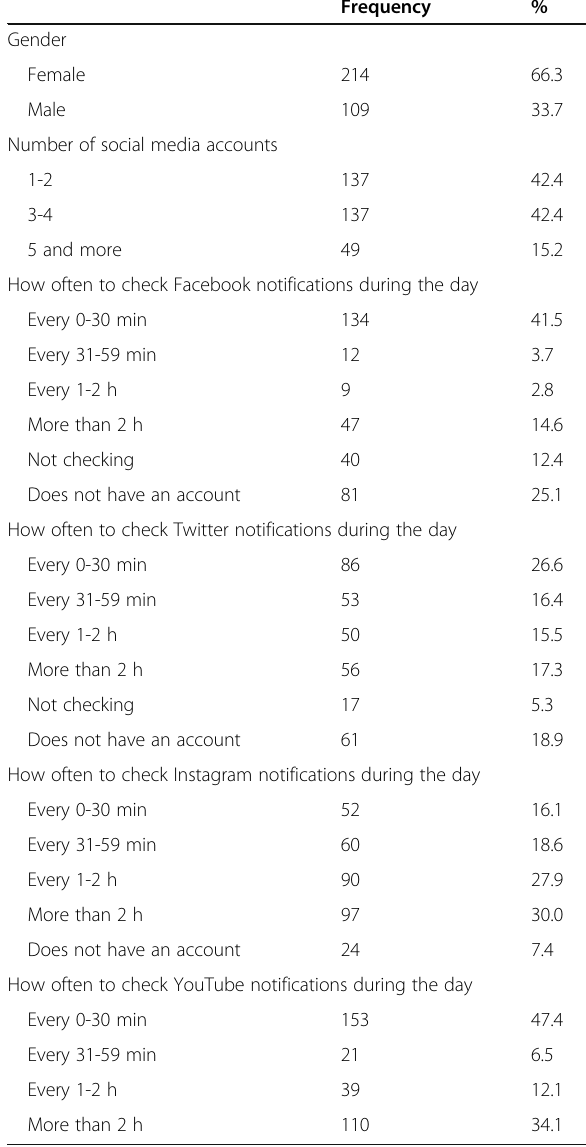
Table 1 Descriptive information of the